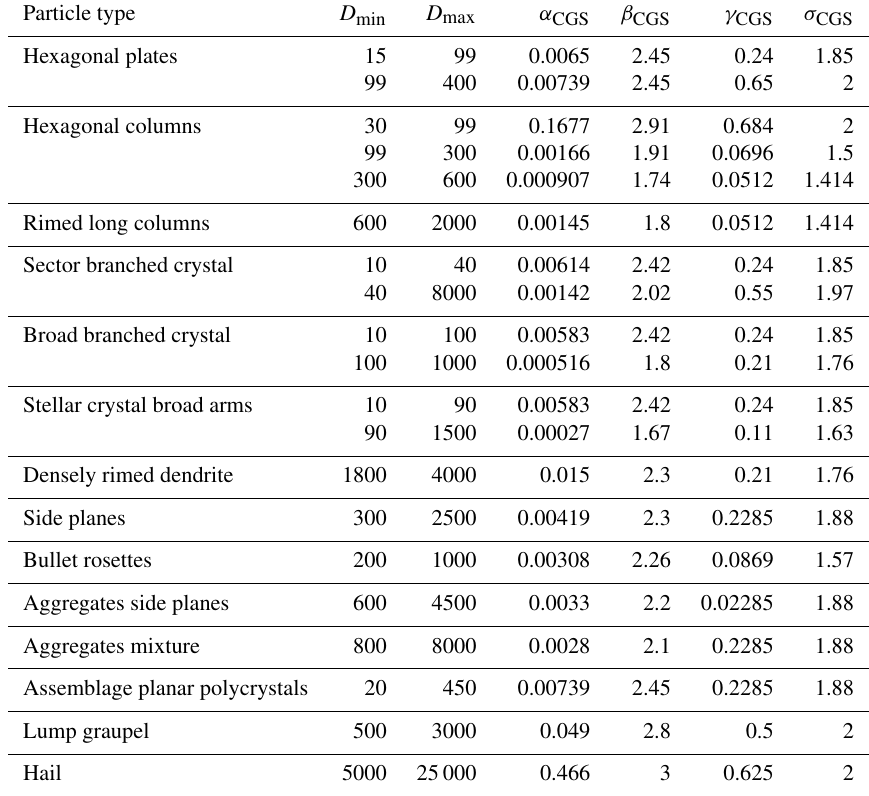
Table A1. Values for α , β , γ and σ as well as their valid ranges ( D min ...D max in µm) used in the context of this work.